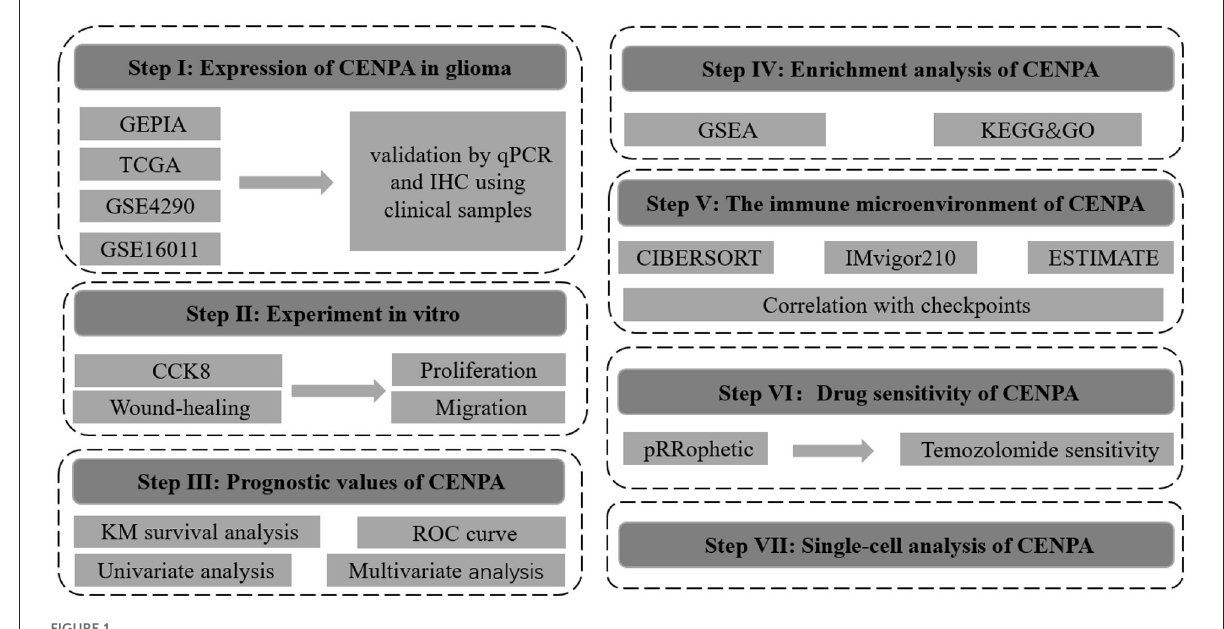
FIGURE1 Flowchart of this